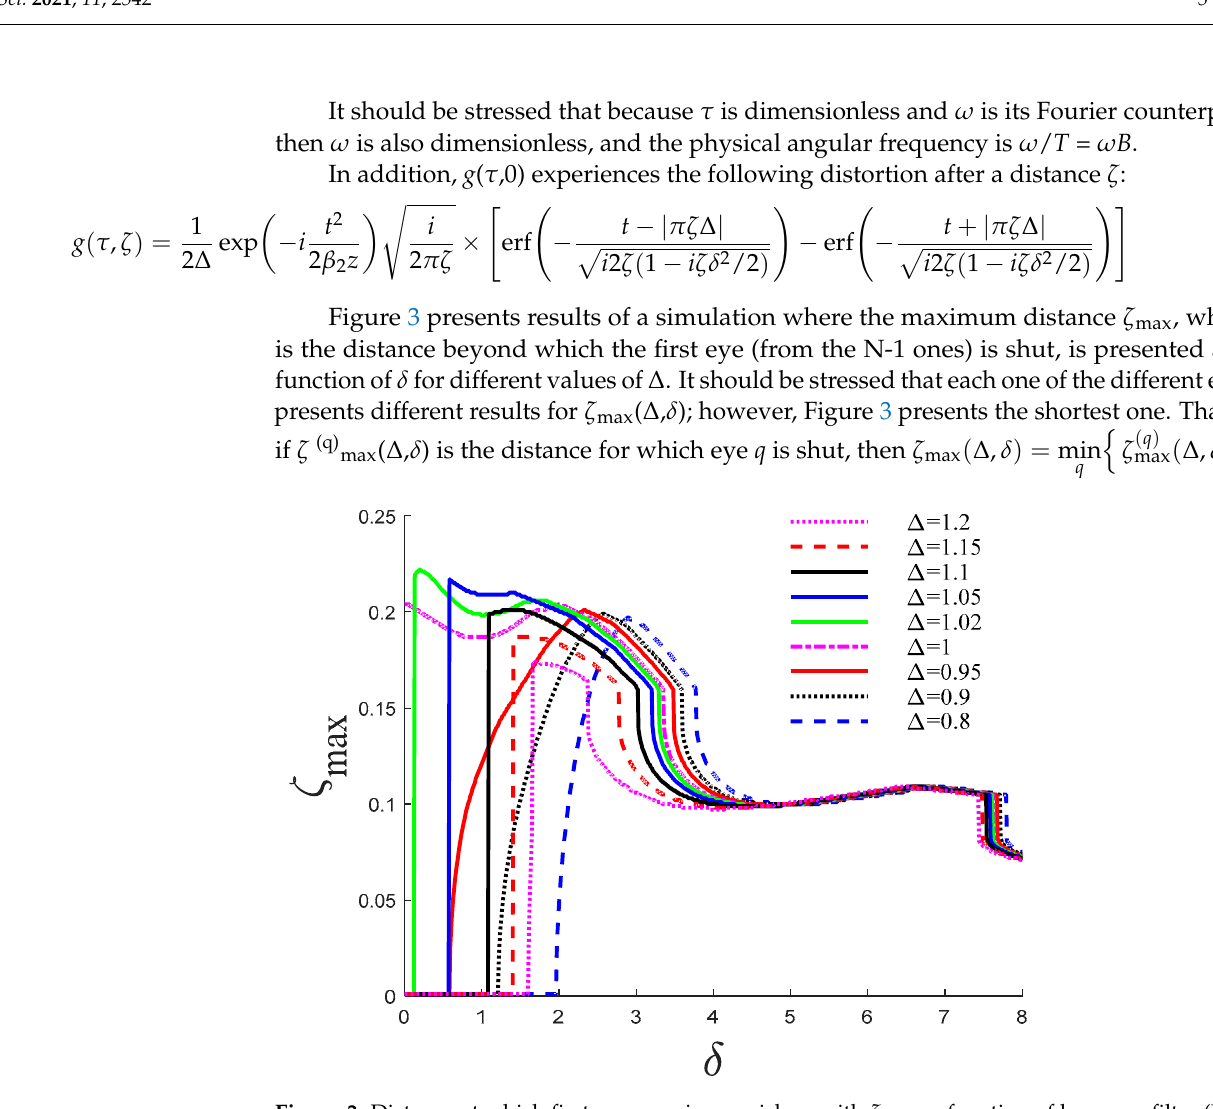
Figure 3. Distance at which first eye-opening vanishes, with ζ max as function of low pass filter (LPF) parameters Δ and δ .